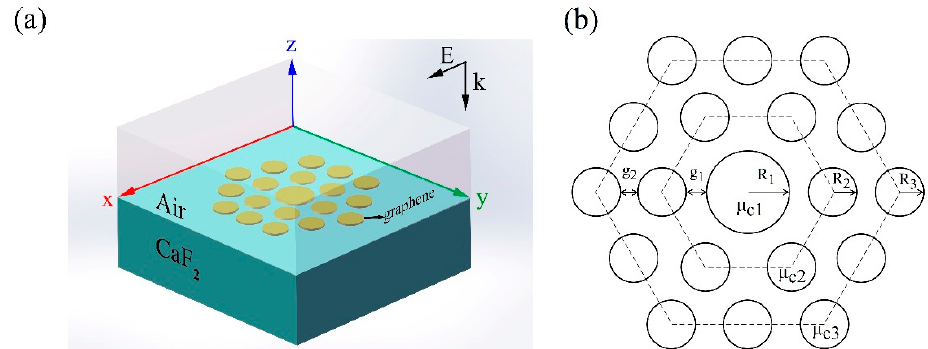
Figure 1. ( a ) Schematic of the graphene metamolecule. Nineteen nanodiscs are placed on a CaF 2 substrate and are surrounded by the air. The incident light is polarized along the x-axis. ( b ) The top view of the graphene metamolecule: gap g 1 = 10 nm, gap g 2 = 30 nm, radius R 1 = 90 nm of the central nanodisc, radius R 2 = 50 nm of the intermediate ring nanodiscs, radius R 3 = 50 nm of the outer ring nanodisks, chemical potential µ c 1 = 0.6 eV, chemical potential µ c 2 = 0.5 eV, and chemical potential µ c 3 = 0.5 eV.